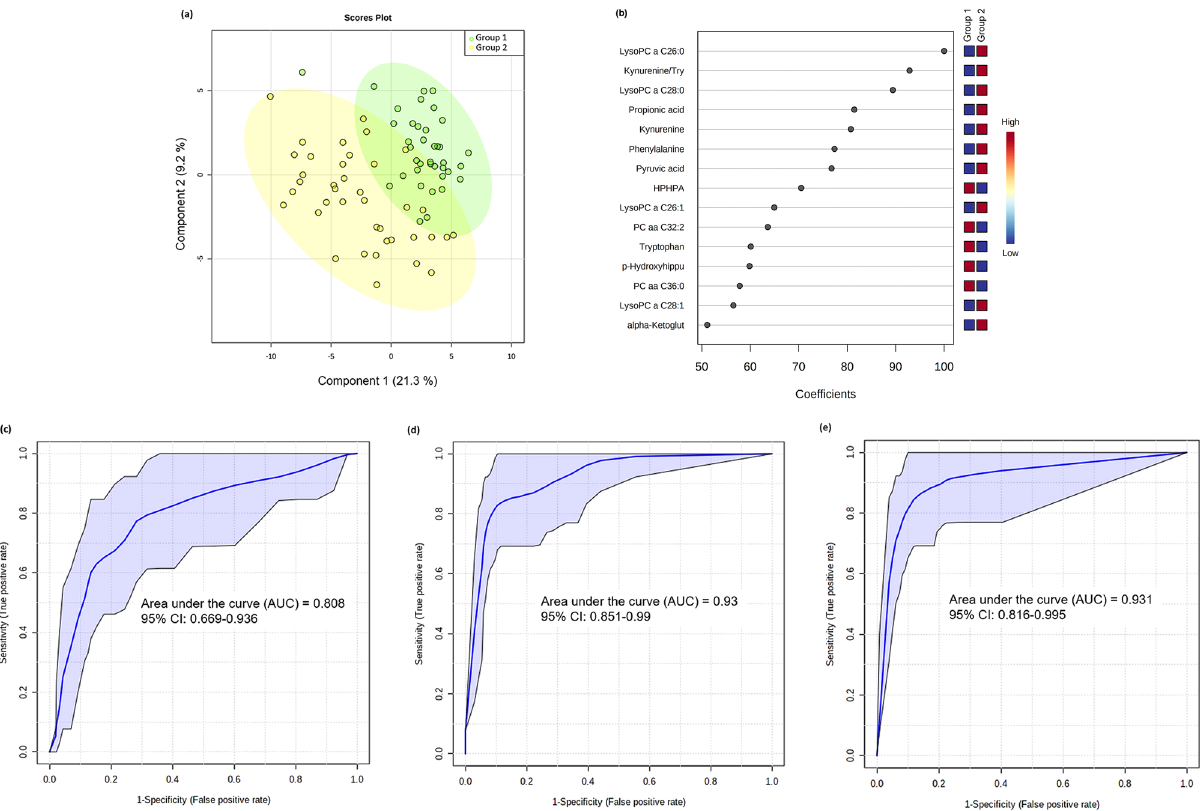
Figure 1. Multivariate analysis from plasma metabolome profile of G1 versus G2 patients. ( a ) Score scatter plot based on the PLS-DA models to explain the diagnosis (green for G1 and yellow for G2; ( b ) rank of the different metabolites (the top 15) identified by the PLS-DA according to the VIP coefficient on the x-axis. The most discriminating metabolites are shown in descending order of their coefficient scores. The color boxes indicate whether metabolite concentration is increased (red) or decreased (blue) in G1 vs G2; ( c ) ROC curve of the demographic/clinical data model; ( d ) ROC curve of the metabolite-only model; ( e ) ROC curve of the metabolite + demographic/clinical data model. The figures were drawn via MetaboAnalyst software v 4.0 (https:// www. metab oanal yst.